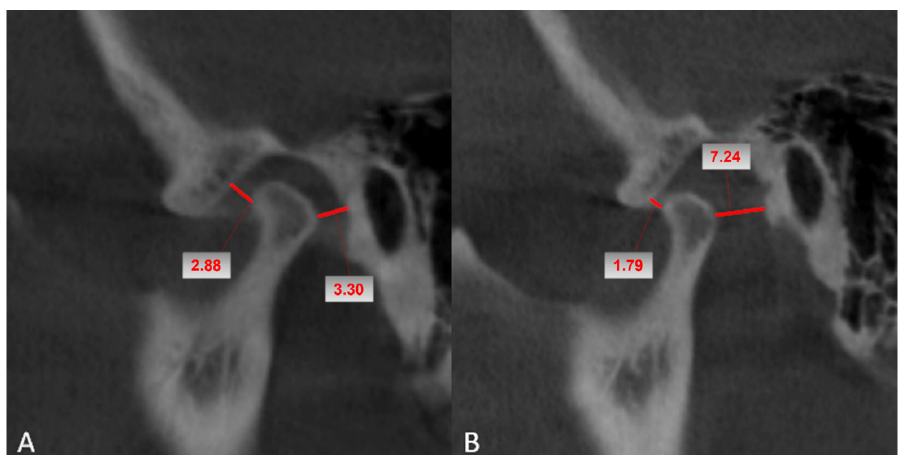
Figure 1. CBCT examination with a closed mouth. Sagittal plane. TMJ anterior and posterior space measurements: ( A ) preoperative, ( B ) postoperative.